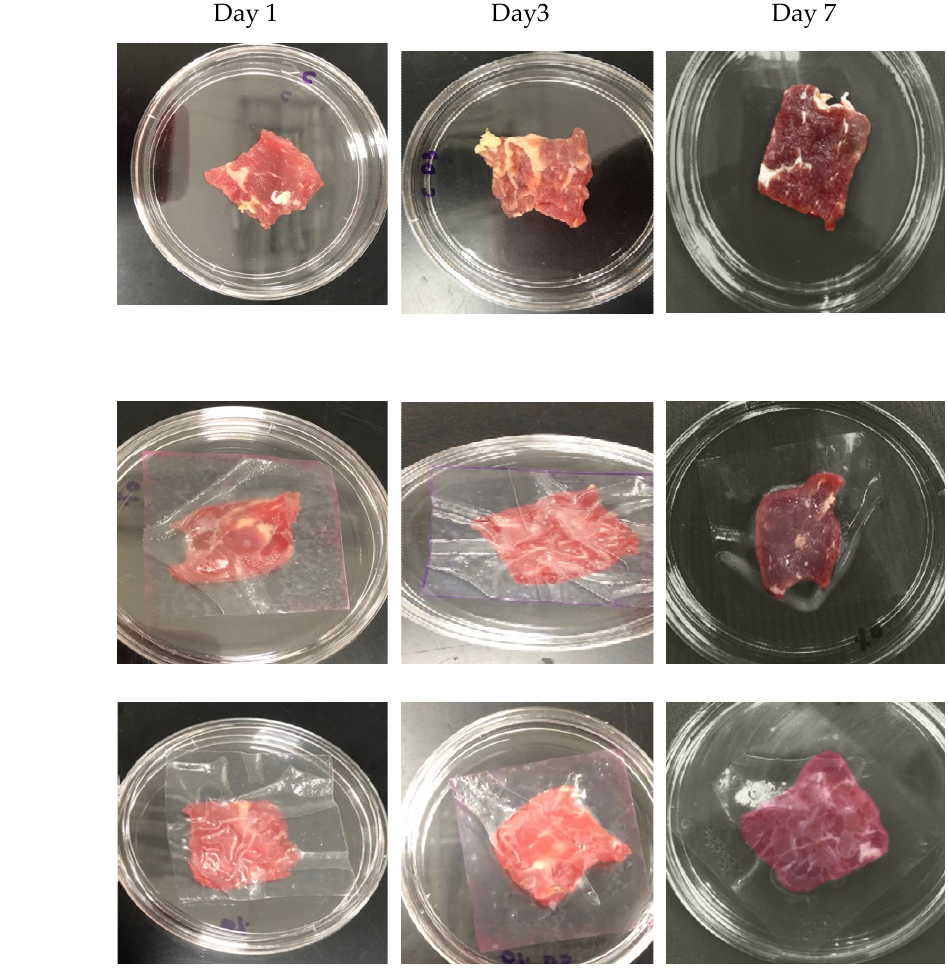
Figure 6. Physical appearance of the meat in direct contact with the films, stored at 13 ° C on days 1, 3, and 7 ( a ) control (no films), ( b ) starch/CNF, ( c ) starch/CNF/thymol-10 wt.%.